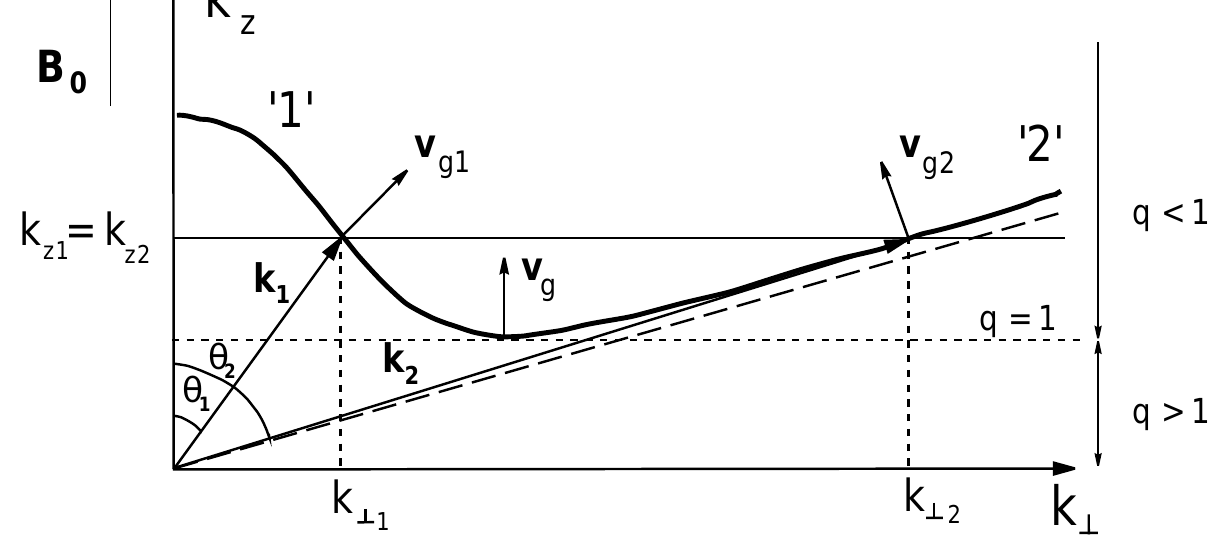
Fig. 1. Whistler dispersion curve in the plane (k ⊥ ,k z ), at a fixed frequency ω < ω c / 2. The so-called electromagnetic and quasi-electrostatic dispersion branches are labelled ‘1’ and ‘2’, respectively; corresponding waves are represented by their wave vectors k 1 (k ⊥ 1 ,k z 1 ) and k 2 (k ⊥ 2 ,k z 2 ) and their angles θ 1 and θ 2 with respect to the ambient magnetic field B 0 (see also Eq. 22), respectively. Group velocity vectors are indicated as v g 1 and v g 2 . The resonance cone is represented by a dashed oblique line. The reflecting surface, where the group velocity v g is directed along B 0 , corresponds to q = 1; waves are not propagating for q > 1 ( q = 4 ω 2 p ω 2 /ω 2 c c 2 k 2 z ). The reflection at q = 1 corresponds to the conversion of an incident electromagnetic whistler (branch ‘1’) to a quasi-electrostatic whistler (branch ‘2’) with conservation of the parallel wave numbers, k z 1 = k z 2 , in the presence of a gradient of plasma density across B 0